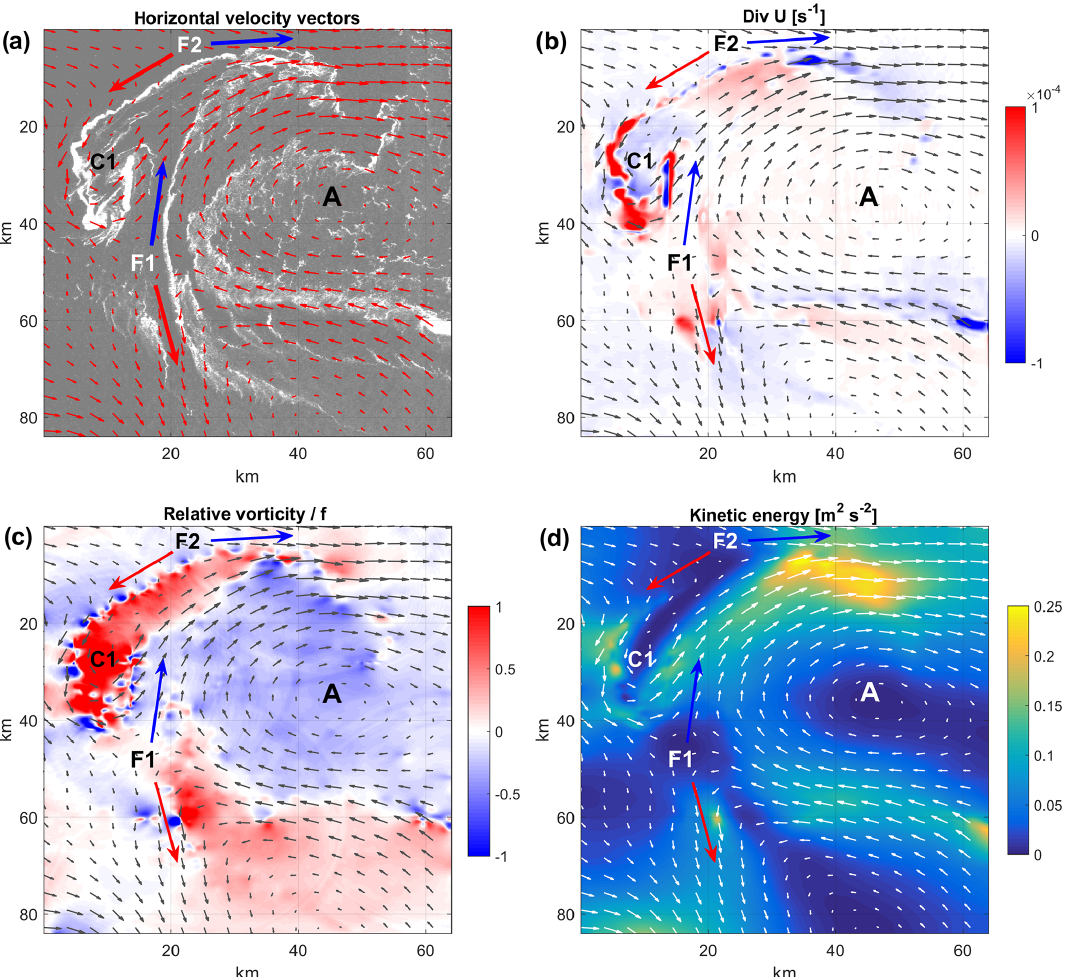
Figure 3. Results for zoomed area over anticyclone A and cyclone C1: (a) horizontal velocity vectors; (b) horizontal divergence; (c) relative vorticity normalized by the Coriolis parameter; (d) kinetic energy. The largest vector in (a) has a magnitude of 0.75ms − 1 . Letters A, C1, F1 and F2 mark the locations of the eddies and filaments described in the text, while blue and red arrows show the movement direction of the filaments F1 and